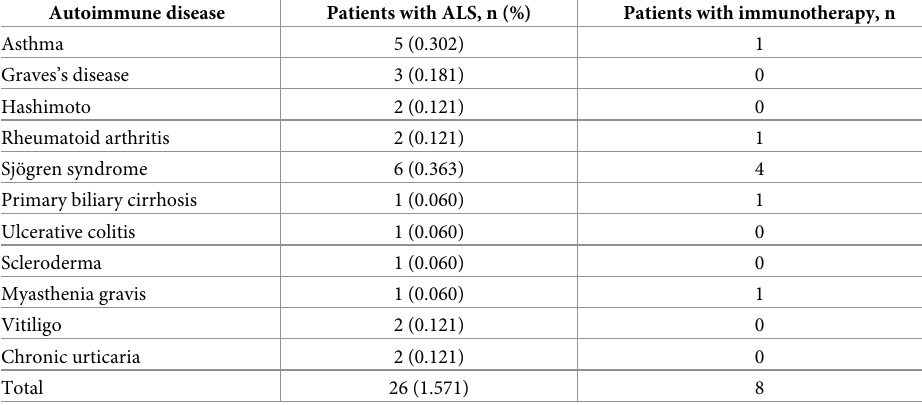
Table 1. Summary of autoimmune diseases in patients with ALS. Autoimmune